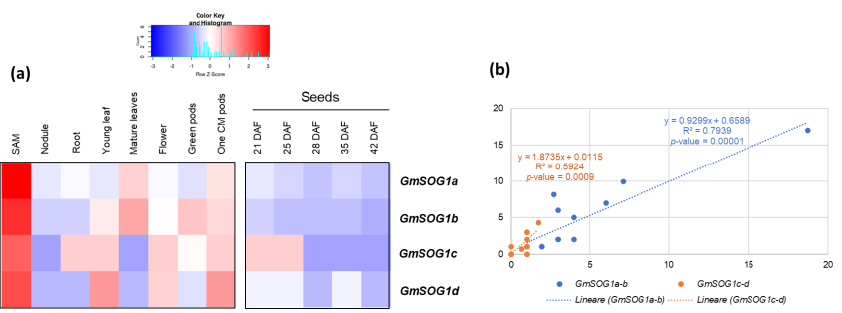
Figure 3. ( a ) Expression profiles of the GmSOG1a (Glyma.02G100200), GmSOG1b (Glyma.20G185800), GmSOG1c (Glyma.10G204700), and GmSOG1d (Glyma.01G088200) genes in G. max . Data were collected from http://bar.utoronto.ca/, accessed on 19 March 2022 and heatmaps were generated using the Shinyheatmap (http://shinyheatmap.com, accessed on 19 March 2022). ( b ) Correlation analysis between GmSOG1a , GmSOG1b , GmSOG1c , and GmSOG1d gene expression val- ues.